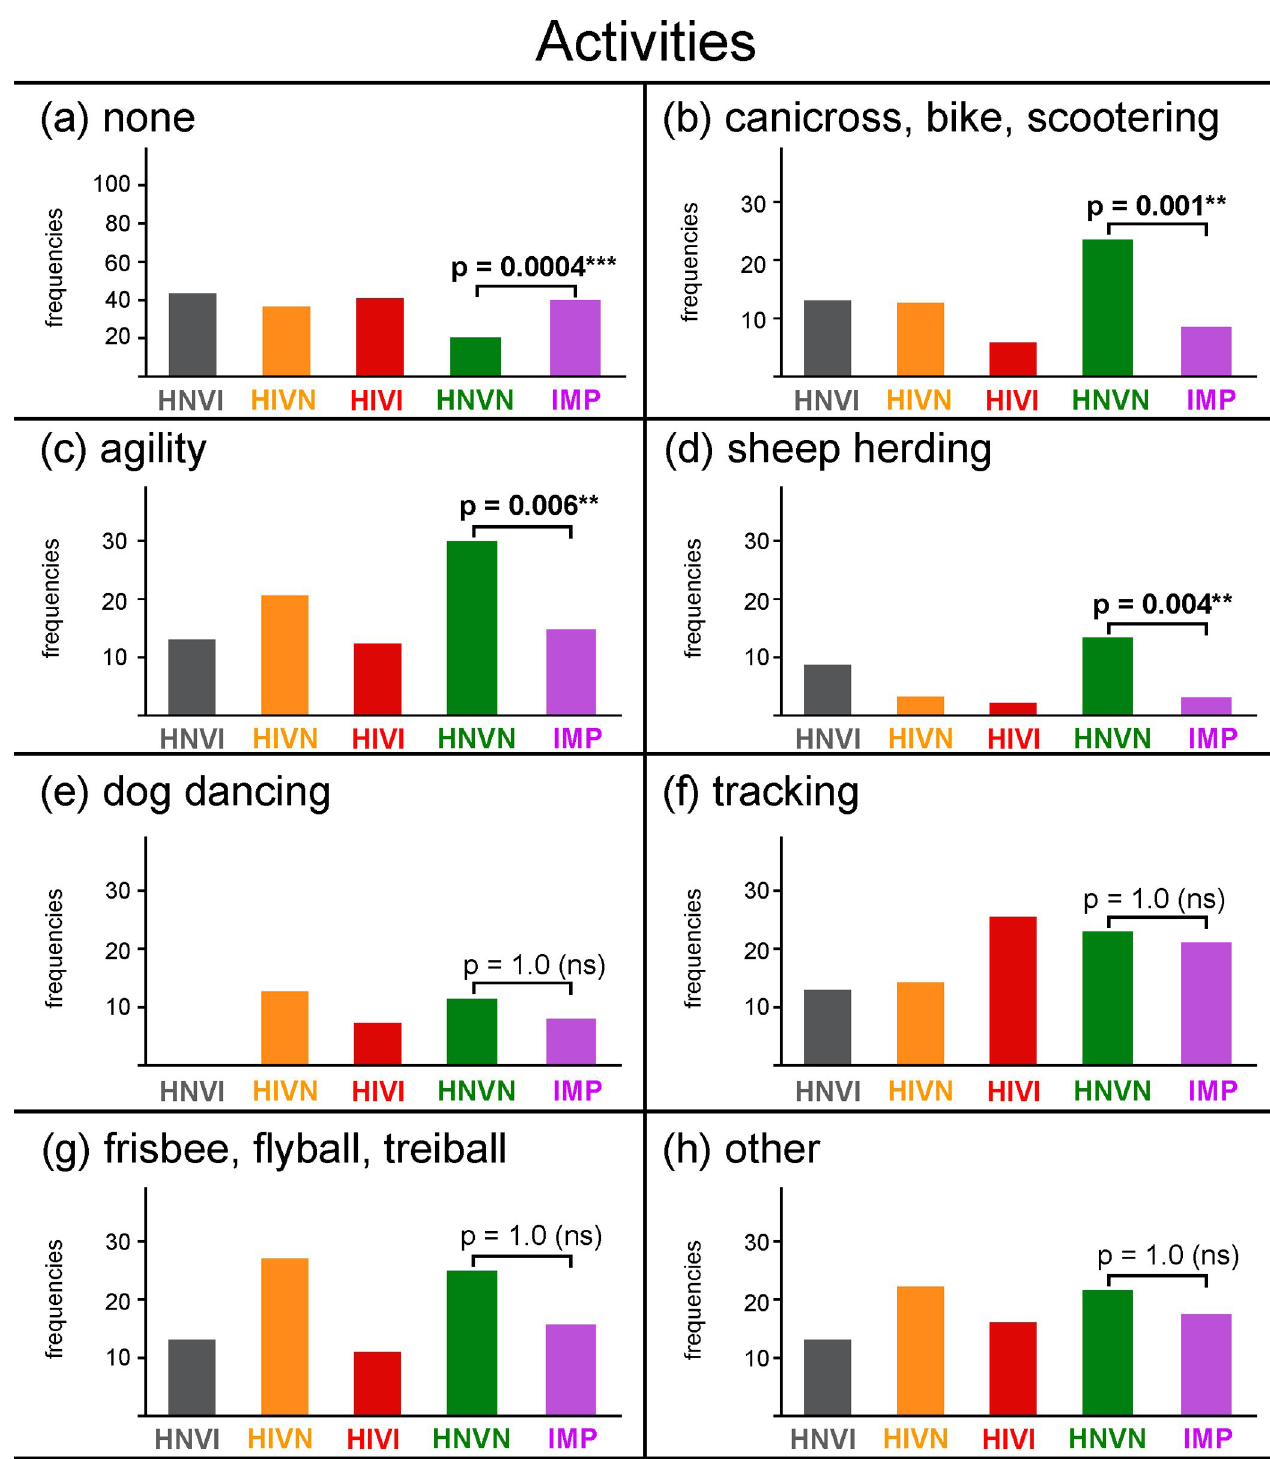
Fig 7. Frequencies of responses, in percentages, obtained for each group and for the IMP cohort for the following leisure/sport activities: (a) none, (b) canicross/bikejoring/scootering, (c) agility, (d) sheep herding, (e) dog dancing, (f) tracking of objects or persons, (g) Frisbee/flyball/treiball, and (h) other. The ordinate width is larger in panel (a) than in panels (b) to (h). HNVI = hearing normal vision impaired (grey), HIVN = hearing impaired vision normal (orange), HIVI = hearing impaired vision impaired (red), HNVN = hearing normal vision normal (green), IMP = impaired (HNVI, HIVN and HIVI gathered, purple), ns = non significant. Horizontal brackets show comparisons between HNVN and IPM assessed using Chi 2 tests.